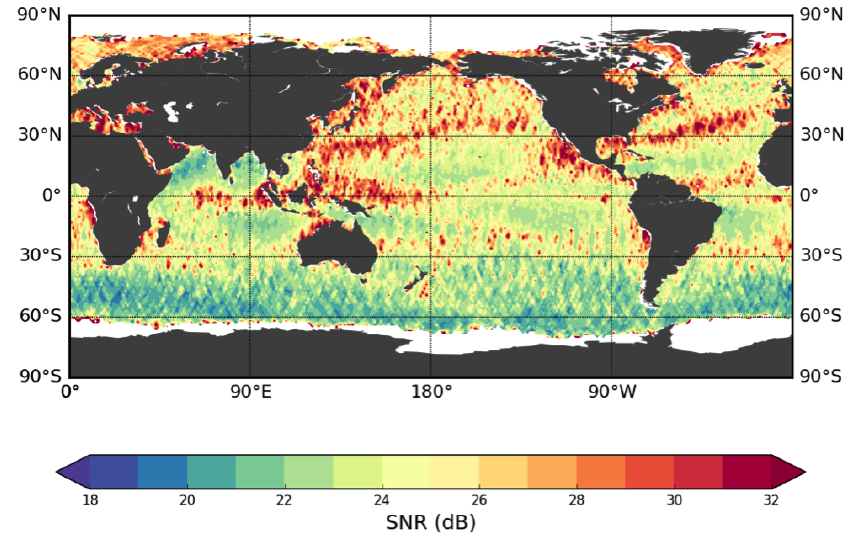
Figure 18. Map of Signal to Noise Ratio computed from standard MLE-4 estimates over ocean for cycle number 110 (from 2017/06/19 to 2017/07/24).